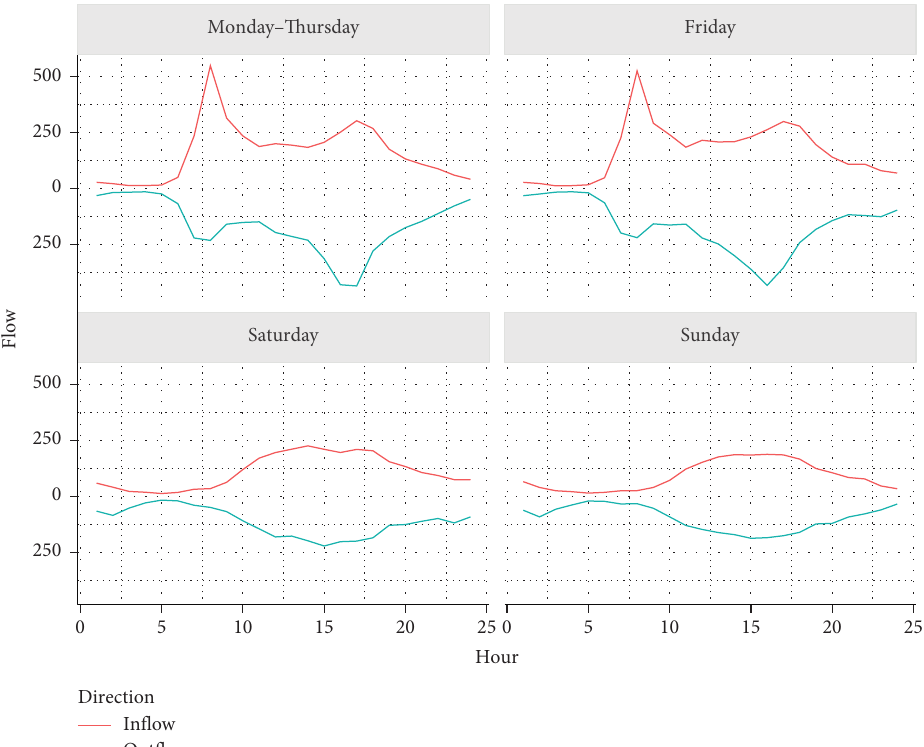
Figure 14: Time distribution of the inflow and outflow of the zone containing the city center of Norrk¨oping using the For Monday–Thursday, an average is presented as these days show very similar